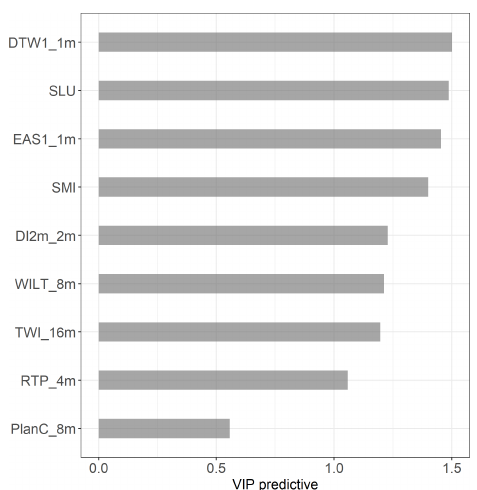
Figure 3. VIP predictive values for the best-performing variable for each terrain index. In OPLS, VIP predictive < 1 are variables that are better at explaining Y